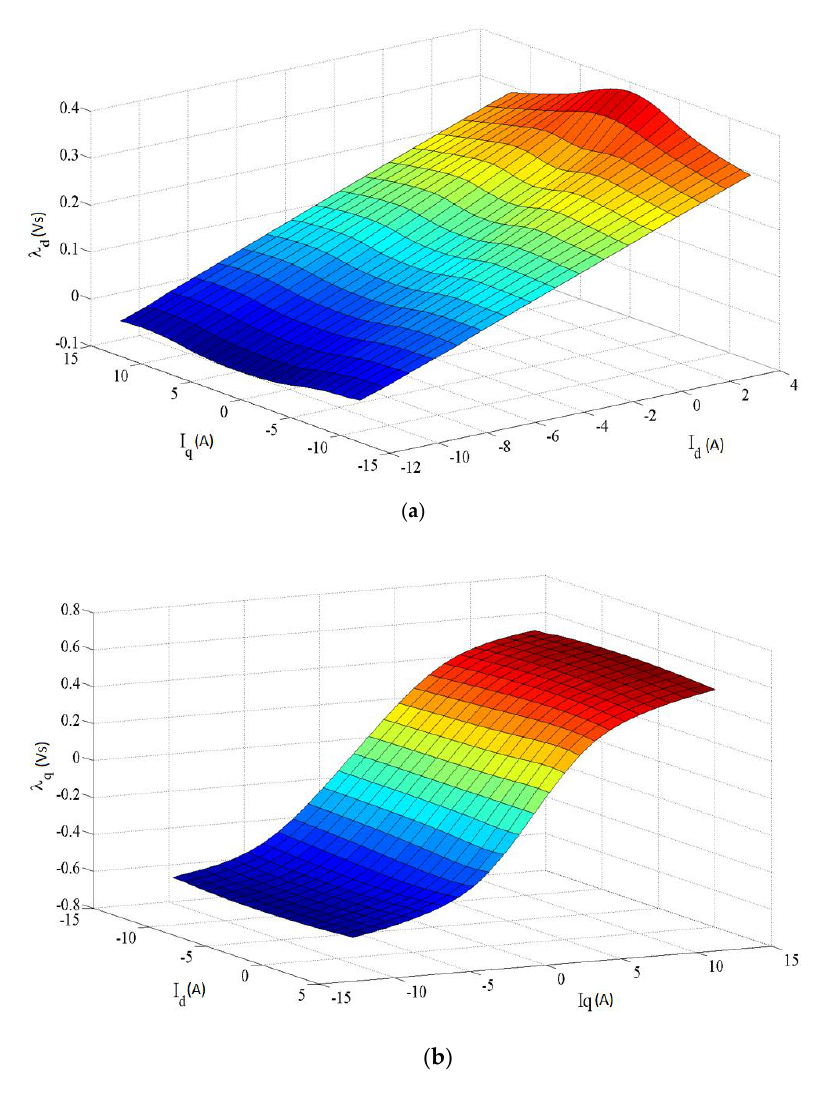
Figure 3. Flux-linkage maps of motor #1 for the 𝑑 -axis ( a ) and 𝑞 -axis ( b ).